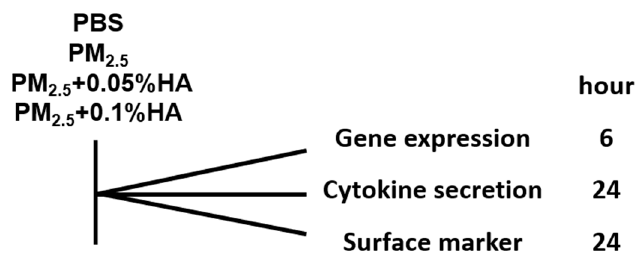
Figure 7. Timeline of in vitro study.